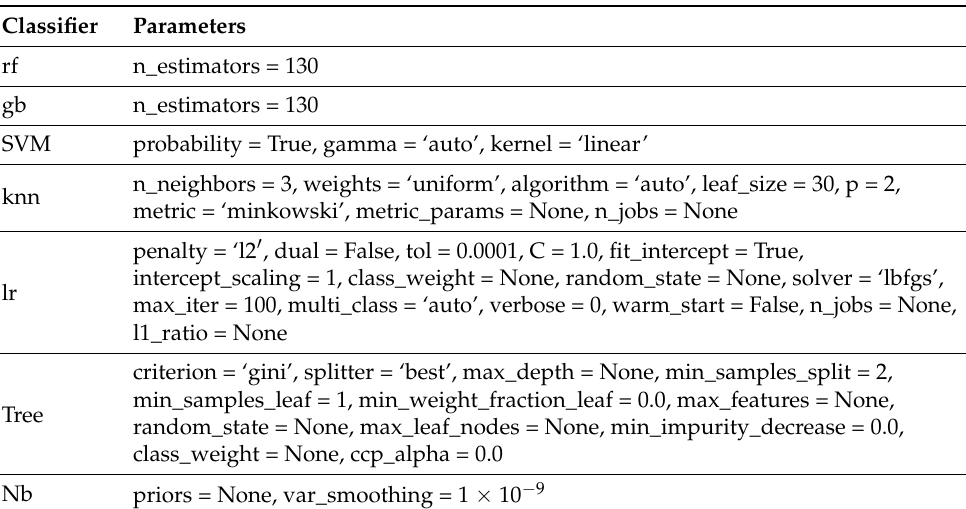
Table A2. Parameters used in modelling the